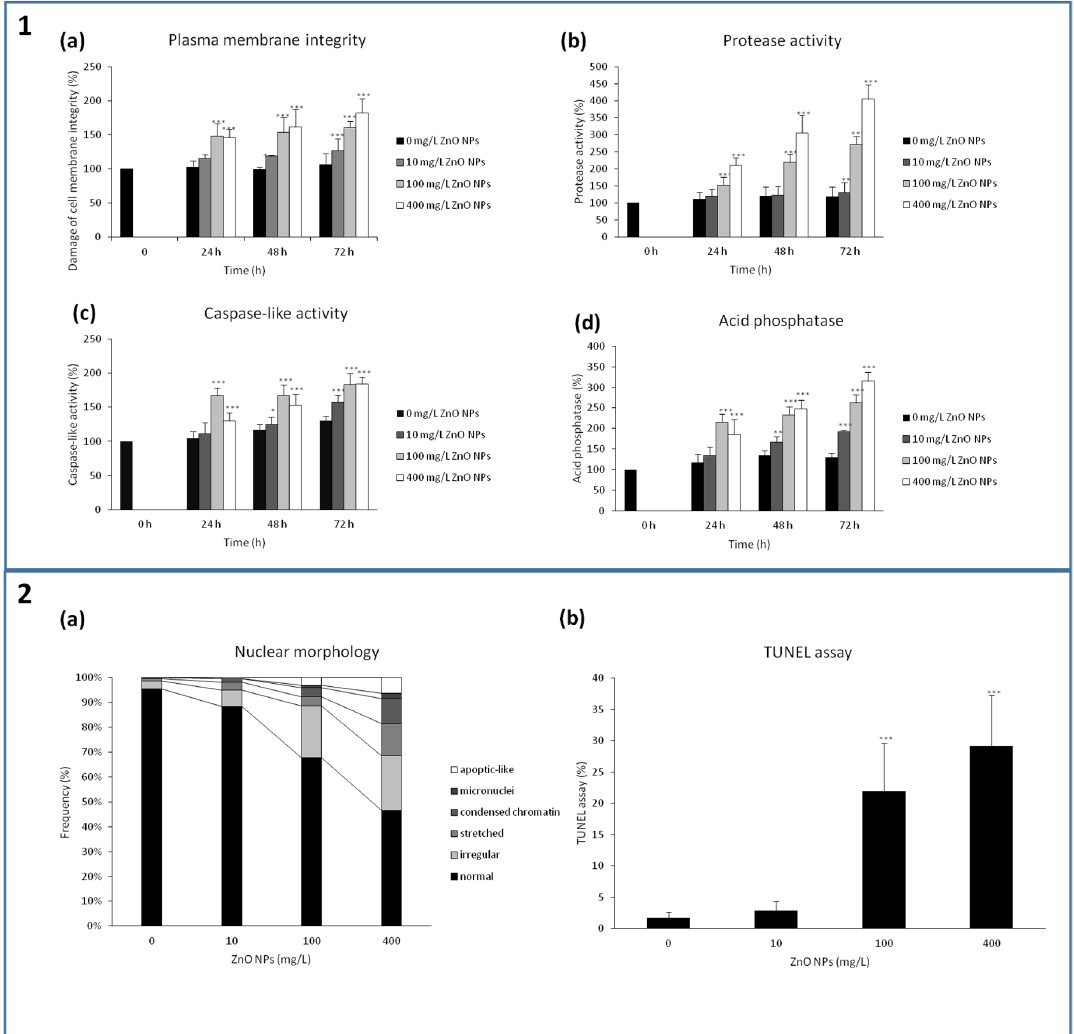
Figure 7. Effect of ZnO NPs on programmed death cell study by plasma membrane activity ( 1a ), effect on autophagy evaluated by activity of proteases ( 1b ), caspase-like activity ( 1c ) and acid phosphatases ( 1d ) after 72 h treatment with 0, 10, 100 and 400 mg/L ZnO NPs. Effect of ZnO NPs on nuclear cell morphology ( 2a ) and DNA fragmentation ( 2b ) after 72 h treatment with 0, 10, 100 and 400 mg/L ZnO NPs. * indicates a significant difference between the BY-2 cells treated with ZnO NPs and the corresponding control (untreated) BY-2 cells at p < 0.05, ** indicates a significant difference between the BY-2 cells treated with ZnO NPs and the corresponding control (untreated) BY-2 cells at p < 0.01, *** indicates a significant difference between the BY-2 cells treated with ZnO NPs and the corresponding control (untreated) BY-2 cells at p < 0.001. Bars represent standard deviations.